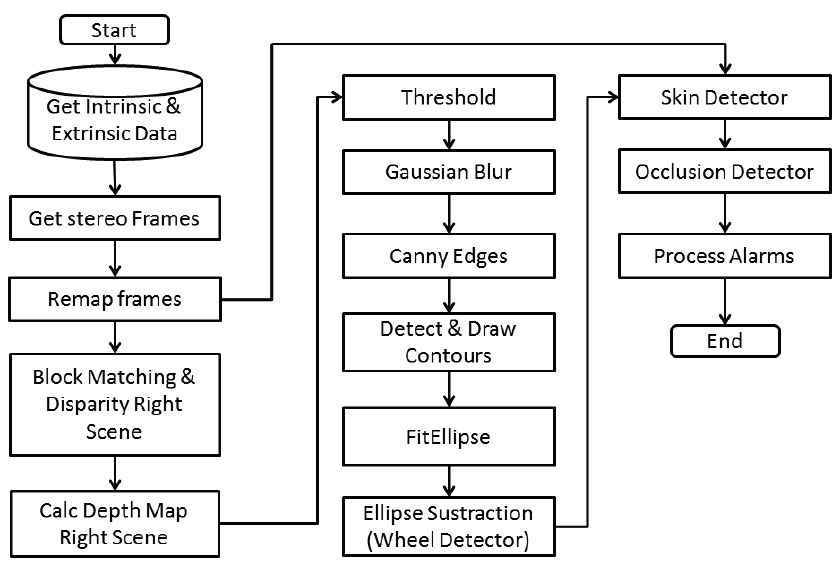
Figure 8. Flow chart alarm mode